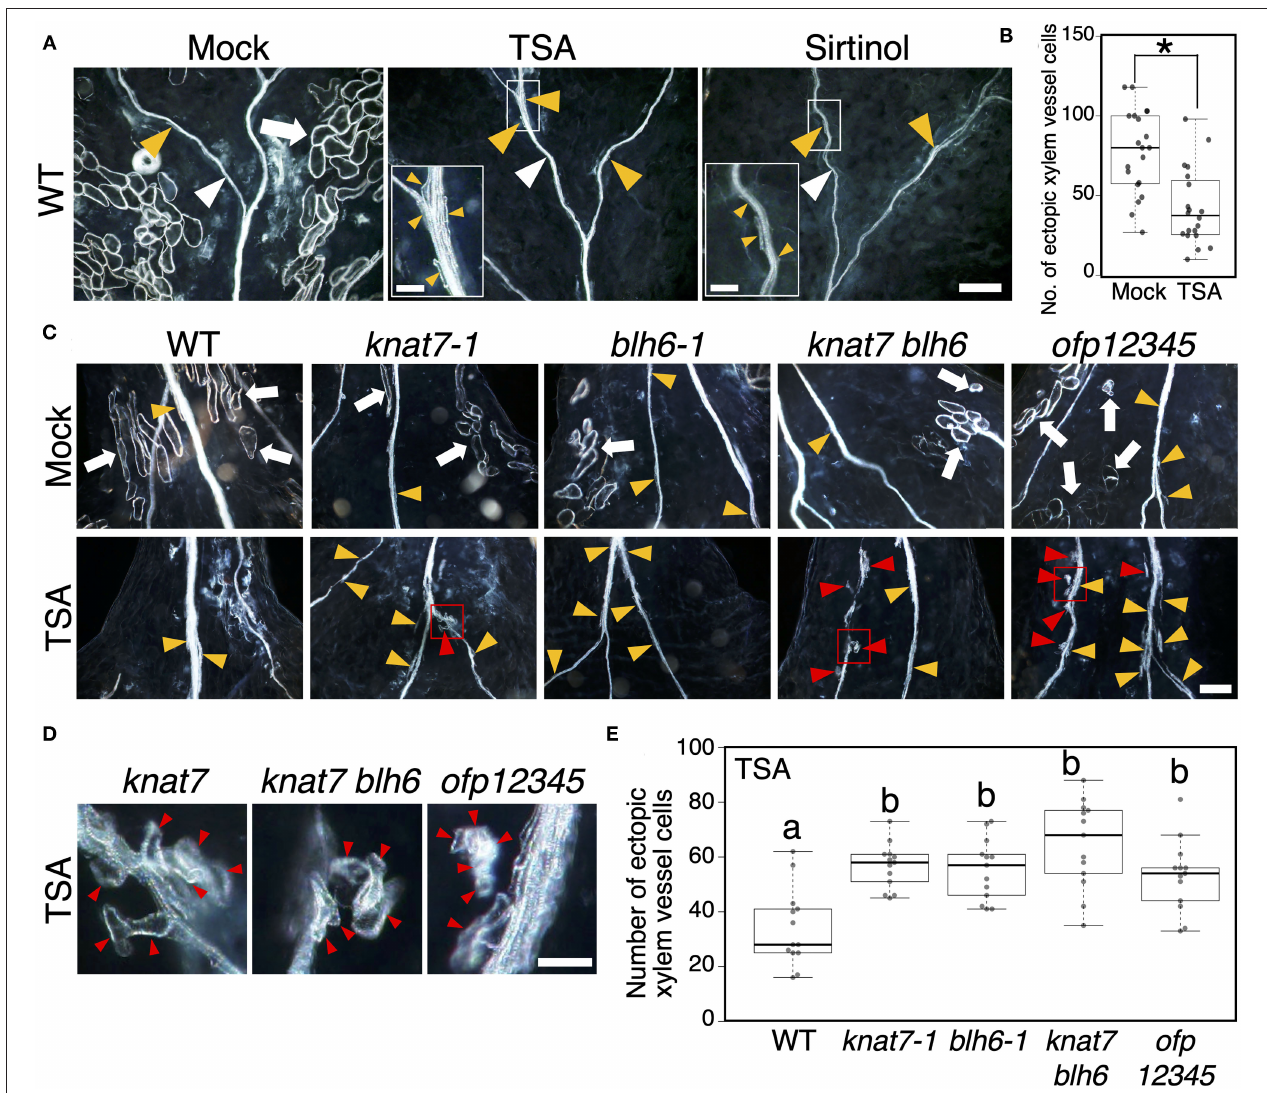
FIGURE 6 | Histone deacetylase inhibitors disturb ectopic xylem vessel cell differentiation in the KDB system. (A) Cotyledons were cut from seven-day-old wild-type seedlings, and ectopic xylem vessel cell differentiation was induced by phytohormonal treatment (the KDB system: Tan et al., 2018), with dimethyl sulfoxide(DMSO) (mock control), 5 µ M trichostatin A (TSA), or 10 µ M sirtinol, for 5 d. An enlarged view of the area enclosed by the white square is shown in the inset. (B) Box plot of the number of ectopic xylem vessel cells per cotyledon ( n = 20). Asterisks indicate statistically significant differences compared with the mock control (Student’s t -test, p < 0.0001). (C) Cotyledons were cut from seven-day-old of wild-type, knat7-1 , blh6-1 , knat7 blh6 , and ofp1 ofp2 ofp3 ofp4 ofp5 ( ofp12345 ) seedlings, and ectopic xylem vessel cell differentiation was induced by phytohormonal treatment (the KDB system: Tan et al., 2018) with DMSO (mock) or 5 µ M TSA. (D) Close-up views of the area enclosed by the red square in (C) . (E) Box plot of the number of ectopic xylem vessel cells per cotyledon under the TSA treatment ( n = 13). Different characters indicate statistically significant differences (Tukey’s test, p < 0.05). White triangles, endogenous xylem vessels; white arrows, ectopic xylem vessel cells transdifferentiated from mesophyll cells; yellow triangles, ectopic xylem vessel cells originating from vascular cells around endogenous xylem vessels; red triangles, ectopic xylem vessel cells located near endogenous xylem vessels originating from non-vascular cells. In box plots, center lines show the medians; box limits